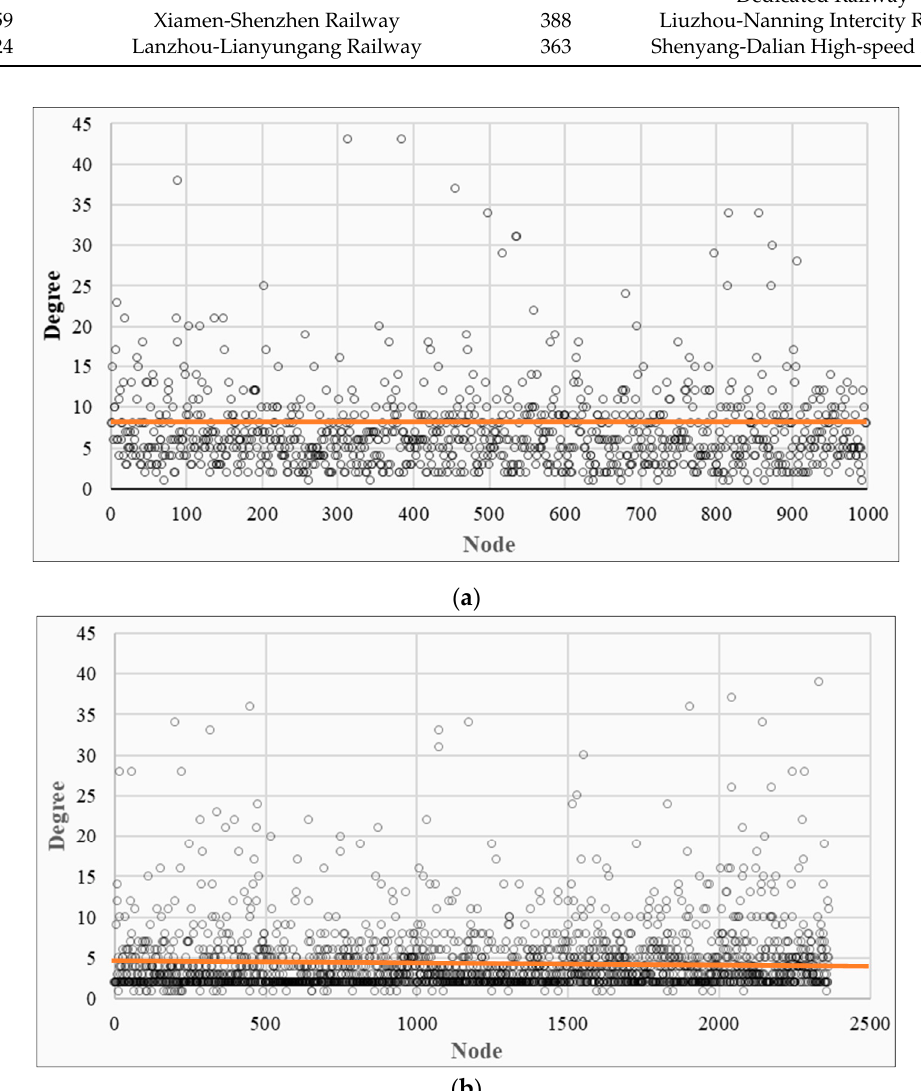
Figure 6. Node degree statistics of the geographic railway network. ( a ) Degree distribution of the high-speed railway network. ( b ) Degree distribution of the normal-speed railway network.